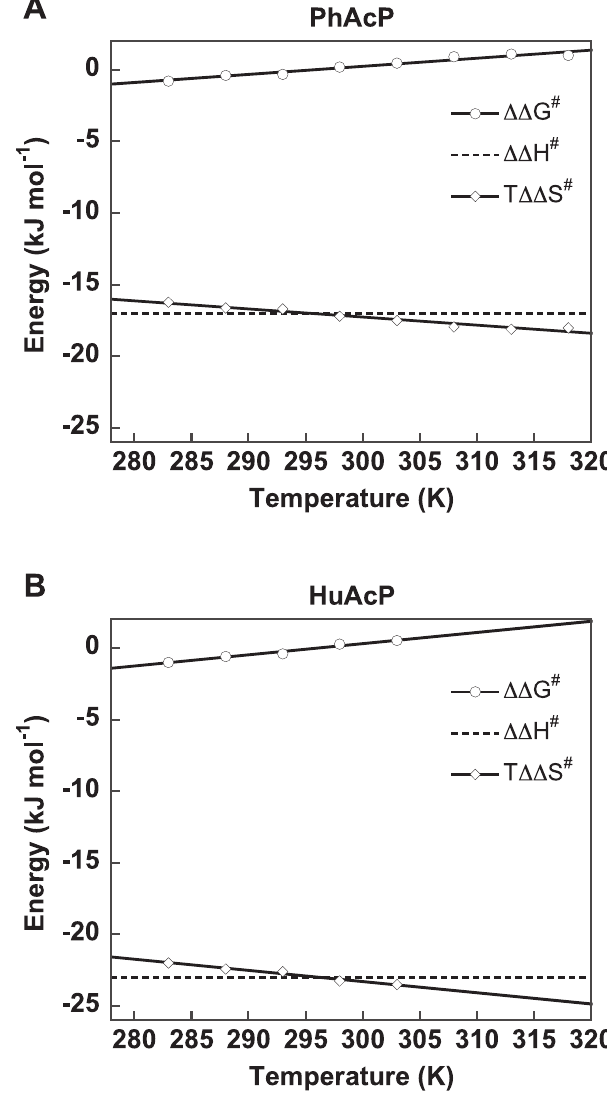
Figure 3. Removal of the active-site salt-bridge decreases both activation enthalpy and entropy. Changes in activation free energy ( DD G # , open circles, solid lines), activation enthalpy ( DD H # , dotted lines), and activation entropy (T DD S # , open diamond, solid lines) upon removal of the active-site salt-bridge were calculated as described in Table 1. As shown, removal of the salt-bridge leads to large negative values of both DD H # and T DD S # , while the effect on activation free energy at , 298 K was minimal due to enthalpy-entropy compensation.